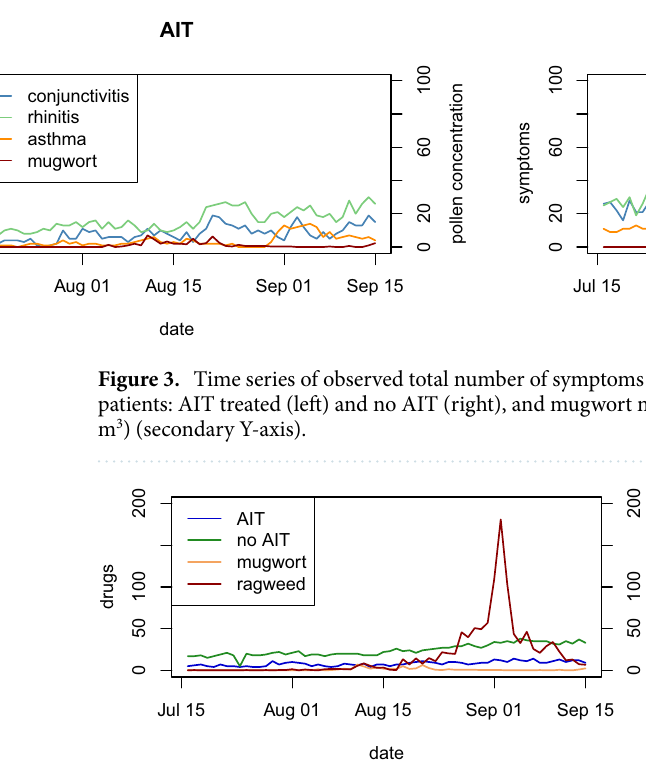
Figure 4. Time series of observed drugs use in the two groups of patients: AIT treated and no AIT, and ragweed and mugwort pollen concentrations (pollen grains/m 3 ) (secondary Y-axis).